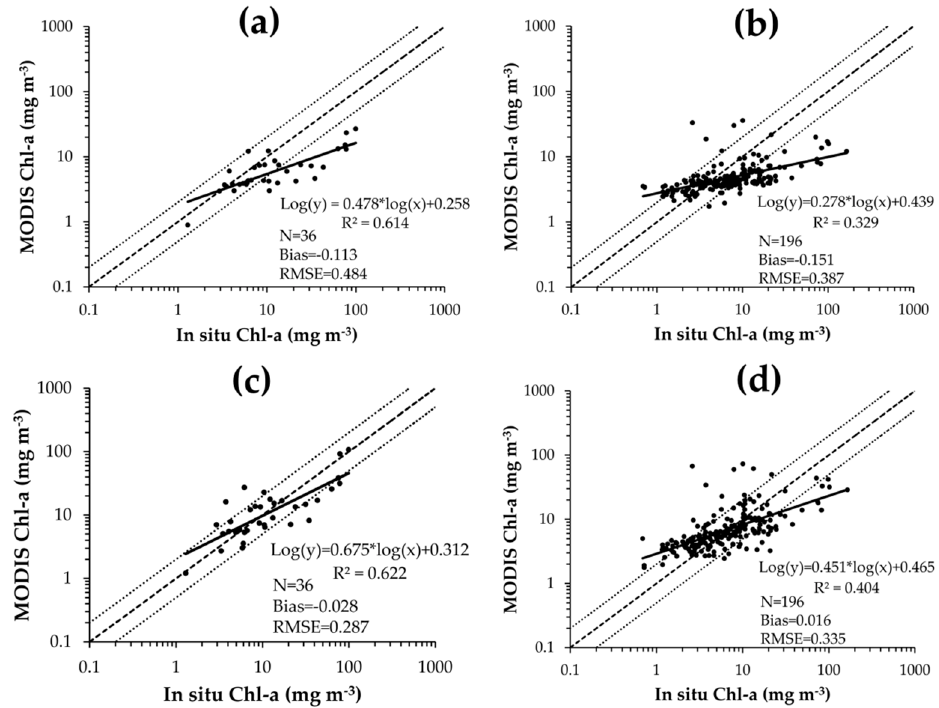
Figure 9. Scatter plots of corrected MODIS Chl-a versus in situ Chl-a collected by Nagoya and Nagasaki universities ( a , c ), and Fisheries Research institutes ( b , d ). The solid and dotted lines are Y = X, Y = 2X, and Y = X/2, respectively. Chl-a calculated using OC3M algorithm ( a , b ) and using new switching algorithm ( c , d ).